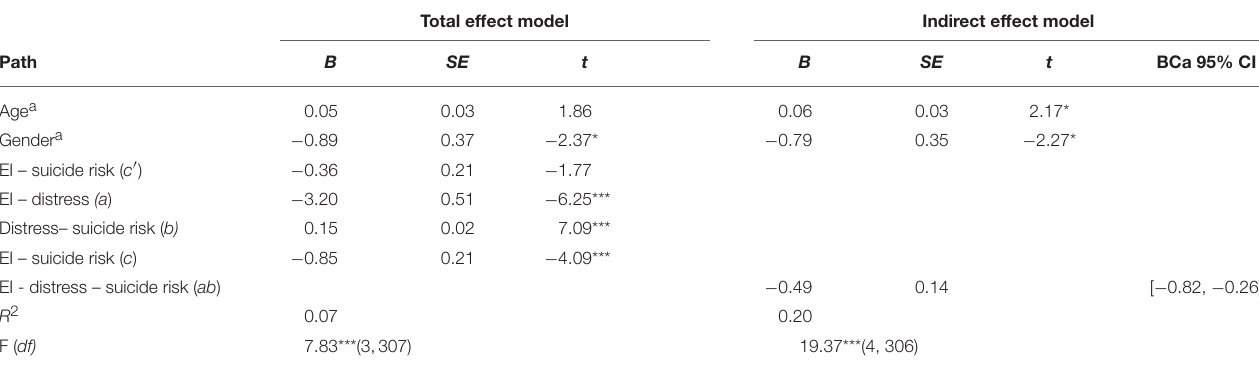
TABLE 4 | Examination of the indirect effect of EI on Time 2 suicide risk through psychological